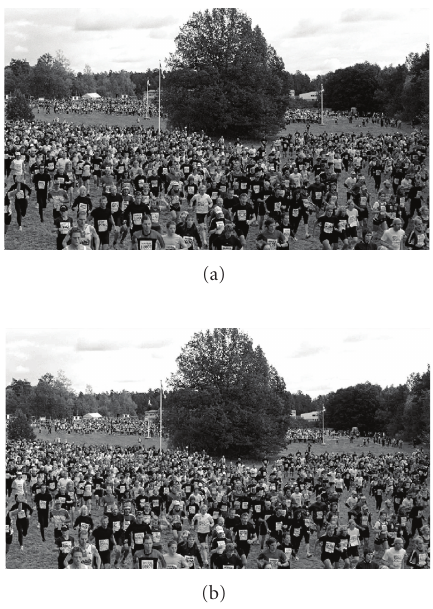
Figure 6: Full reconstruction (a) and single descriptor reconstruc- tion (b) for Crowd Run sequence using MJPEG.